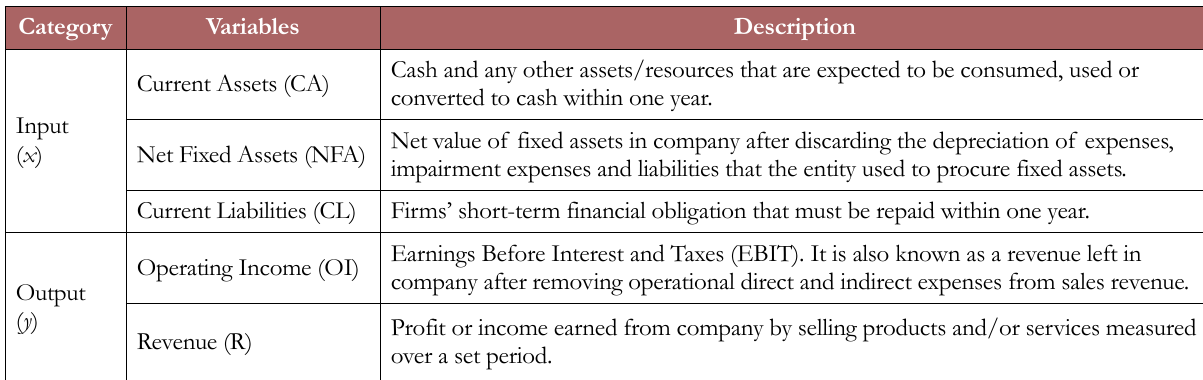
Table 2. Input and output variables of the